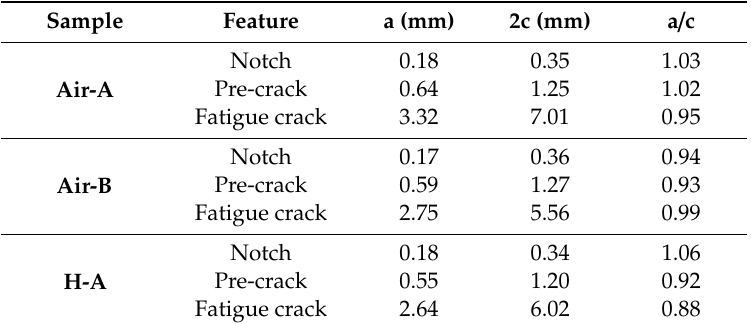
Table 1. Notch, pre-crack, and final fatigue crack lengths (a), widths (2c), and their ratio (a / c), for the three investigated samples Air-A / B and H-A.